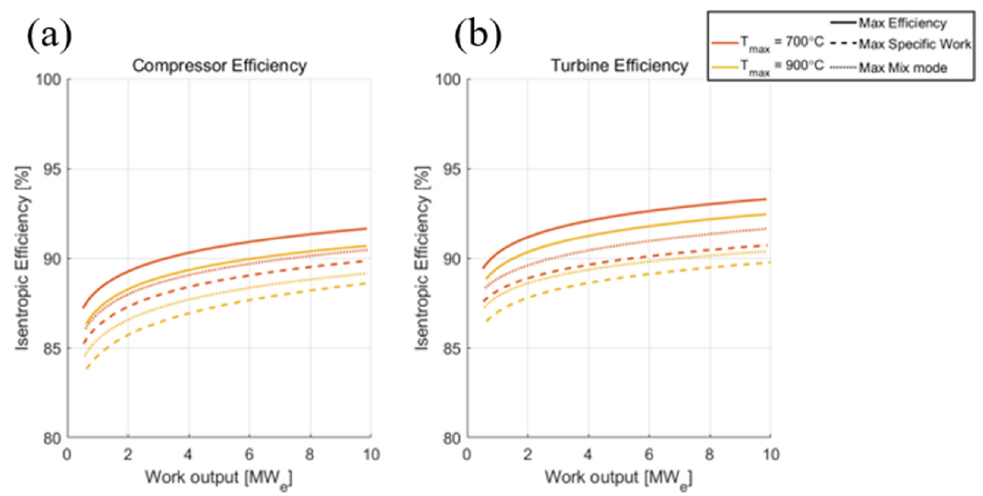
Figure 18. ( a ) Compressor and ( b ) Turbine isentropic efficiency of open-air Brayton Cycle.